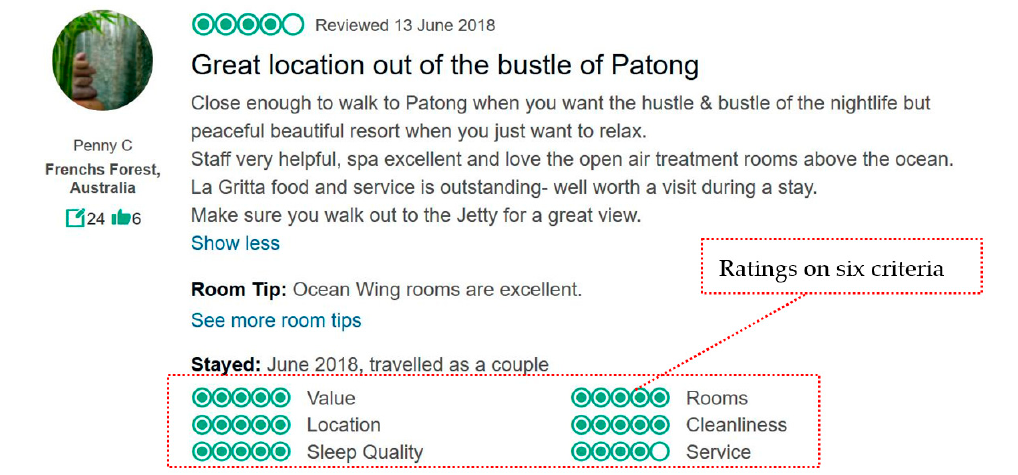
Figure 2. Ratings on six criteria of Amari Phuket given by Penny C.